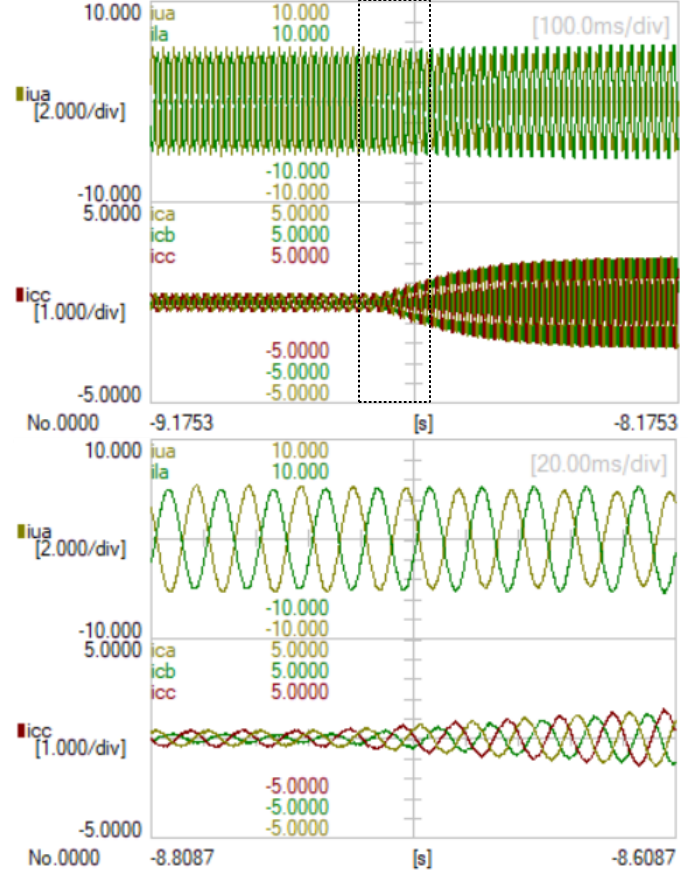
Figure 14. Steady state and dynamic response of current arm and circulating currents in first event. In the second event, the DC voltage v dcl ,2 increased by 60 V, reducing the output power P o by 820 W. This change also reduced the current in the lower arm i l , as seen in Figure 15. To withstand this second power difference, the circulating current i cq remained as it was in the previous event; therefore, the angle difference between the current arms did not change. There was a small perturbation in the circulating current, while the power provided by module M l 2 decreased. This behavior was due to the severe change in the d component of the circulating current as a consequence of the power difference between both arms. Even though the circulating current flowed through the converter, it did not have any impact on the output power, as seen in Figure 16, demonstrating that the power delivered to the grid relied upon the output current, while the power imbalance depended on the circulating